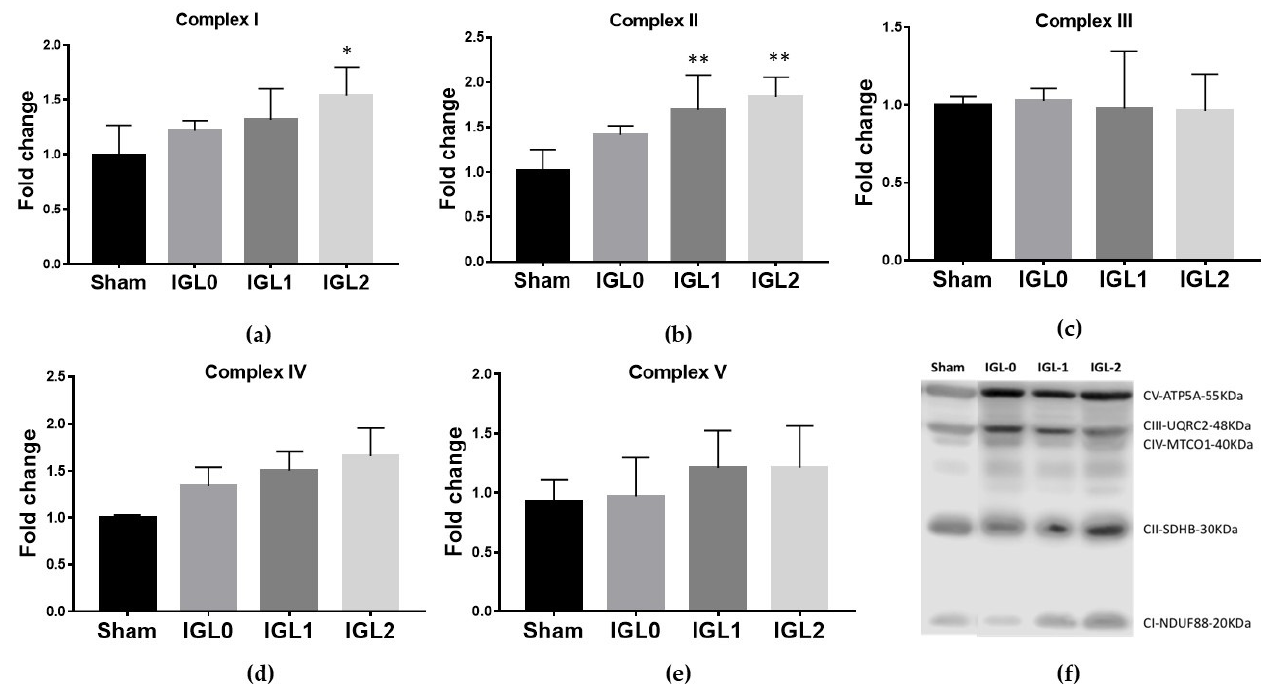
Figure 2. Oxidative phosphorylation complexes (OXPHOS) expression levels in complex I NADH– coenzyme Q oxidoreductase ( a ), complex II succinate–coenzyme Q oxidoreductase ( b ), complex III coenzyme Q-cytochrome C oxidoreductase ( c ), complex IV cytochrome C oxidase ( d ), complex V ATP synthase ( e ), and representative blots of OXPHOS in steatotic livers preserved (4 °C, 24 h) ( f ) in IGL-0, IGL-1 and IGL-2 solutions, vs. Sham. The bars represent the mean values ± SDs of each group ( n = 4–6). Differences are shown comparing groups (* vs. Sham), according to the one-way ANOVA test and the Tukey post-hoc test (one symbol indicates p < 0.05; two symbols indicate p < 0.01; three symbols indicate p < 0.001).